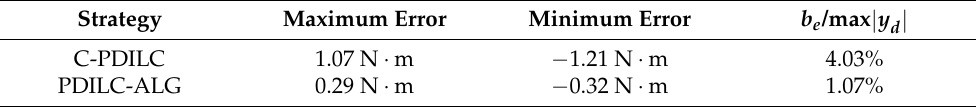
Table 5. Case 1 ( θ ∗ a ( t ) = 8 ◦ sin ( 2 π ih ) , y d ( t ) = 30sin ( 2 π ih ) ) experimental results of the two controllers.